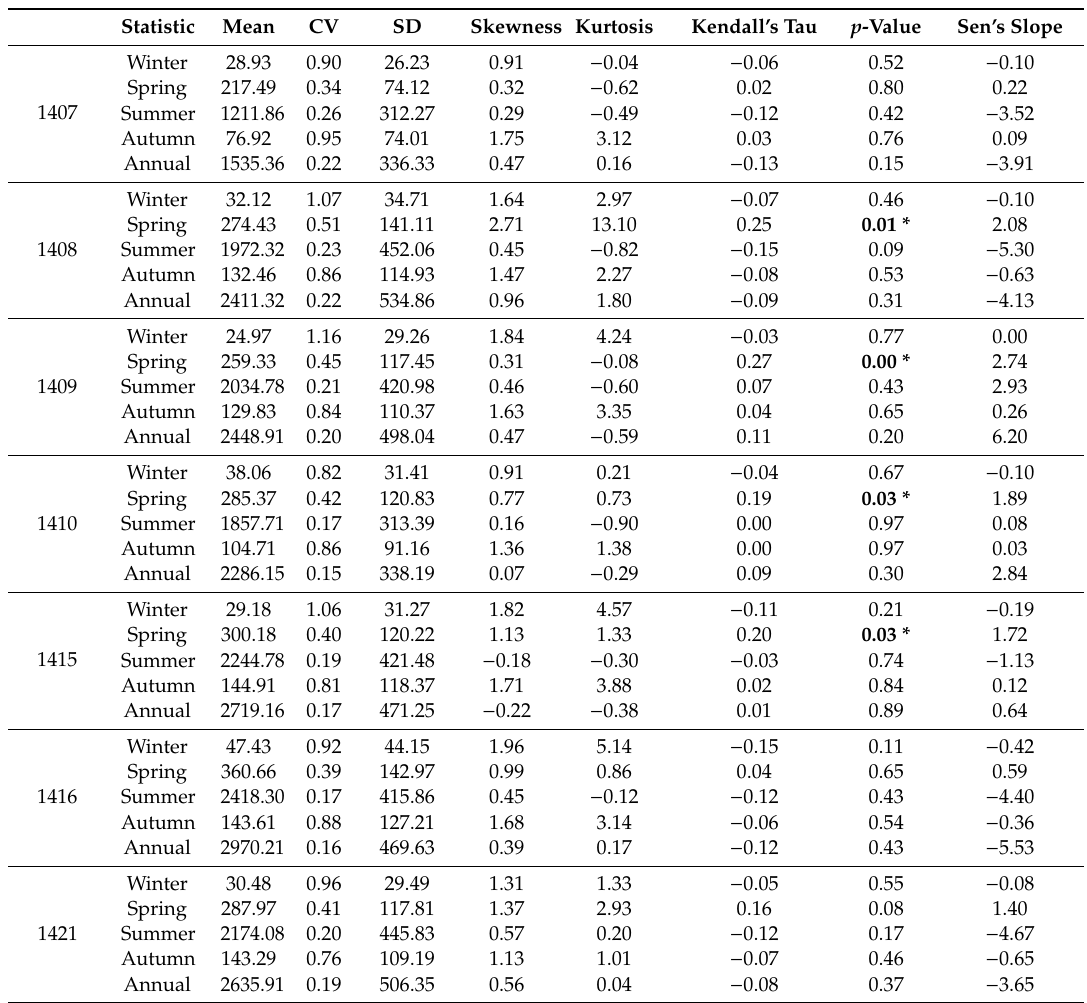
Table 3. Statistical description and trend analysis of seasonal and annual rainfall for time period (1961–2018).